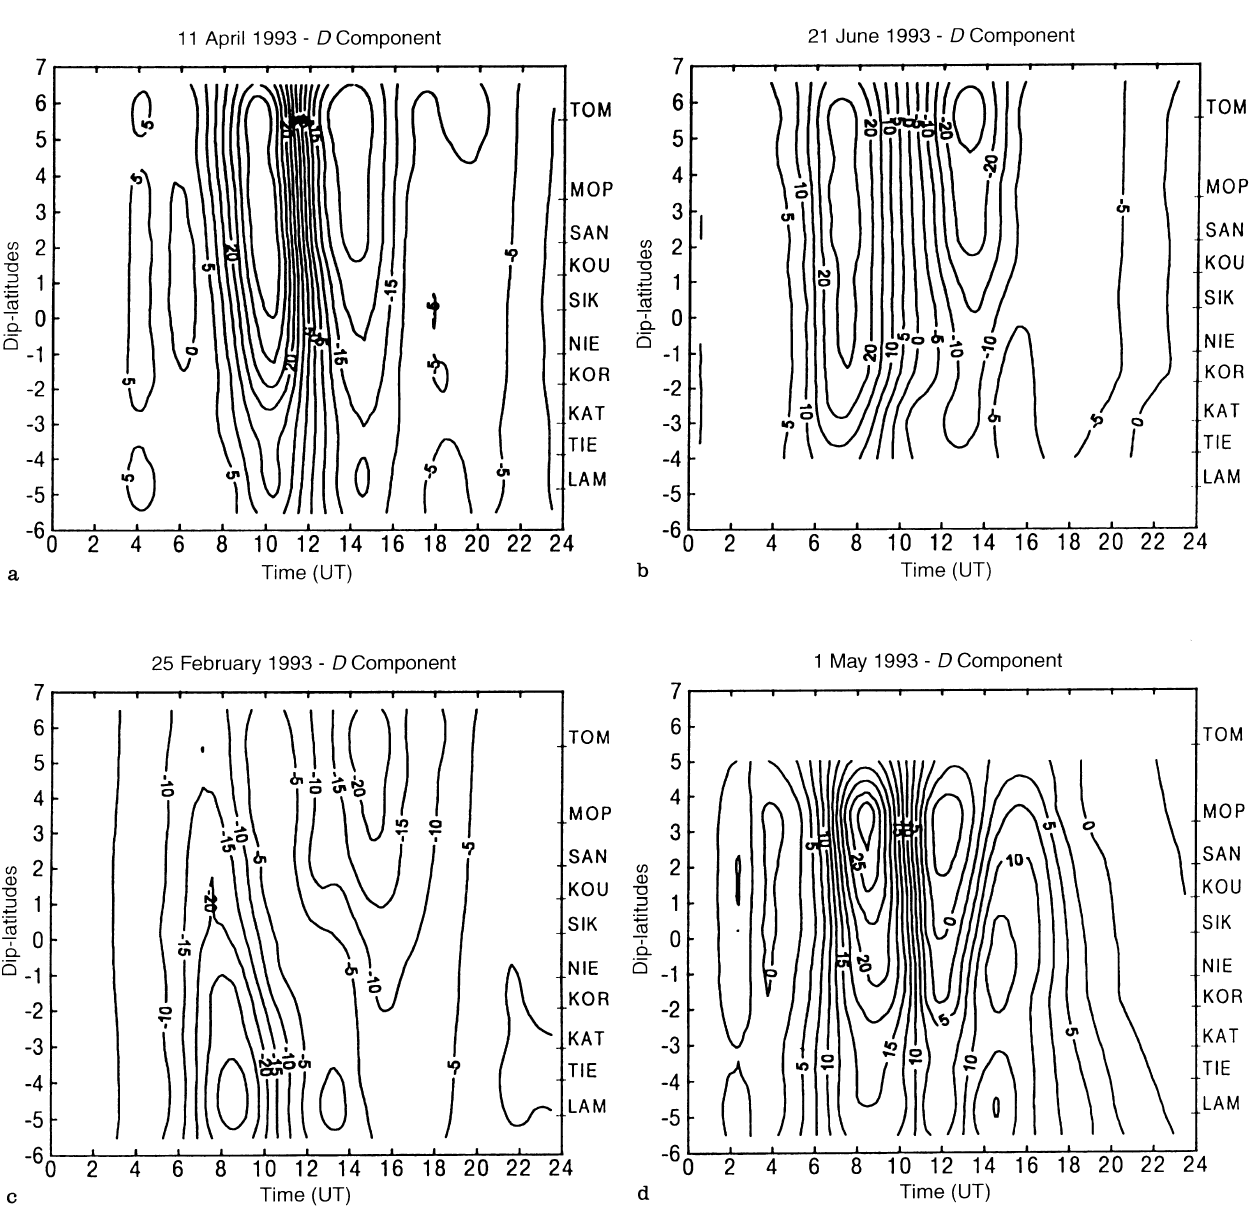
in the afternoon (25 February 1993). d A day when a north e(cid:128)ect is stronger in the morning and a south e(cid:128)ect is dominant in the afternoon (1 May 1993). See text